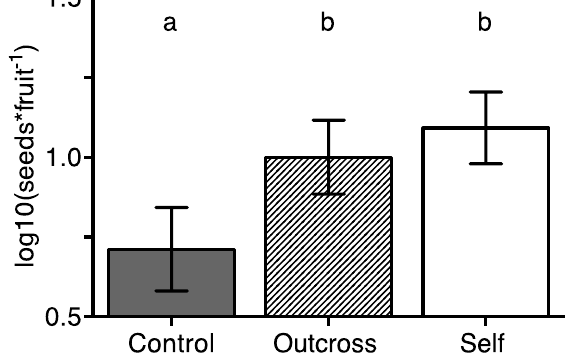
F IGURE 1. Log-transformed numbers of seeds produced per fruit in unpollinated control flowers, flowers that were outcrossed with pollen from other individuals, and flowers that received only self pollen. Data presented are means ± SE, and means that are significantly different are marked with different lower case